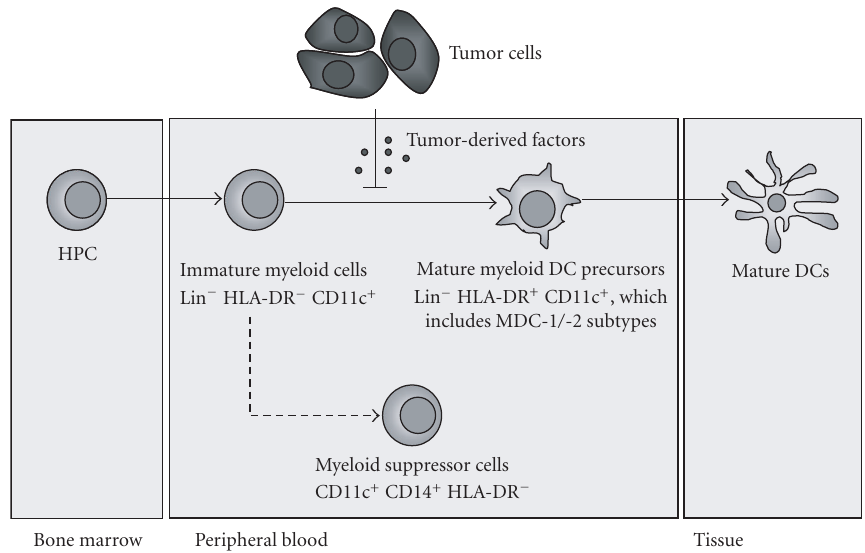
Figure 1: A model of myeloid dendritic cell di ff erentiation under cancer conditions, in which tumor-derived factors exert their inhibitory e ff ect at the stage of immature Lin − CD11c + HLA-DR − myeloid cells (ImCs), blocking their di ff erentiation into mature myeloid DC precur- sors (pMDC), while, simultaneously, skewing their di ff erentiation towards a population of CD14 + HLA-DR neg/low myeloid suppressive cells (MSCs). HPCs: hematopoietic cells; Lin: lineage markers (CD3, CD14, CD19, and CD56); MDC: myeloid dendritic cell.